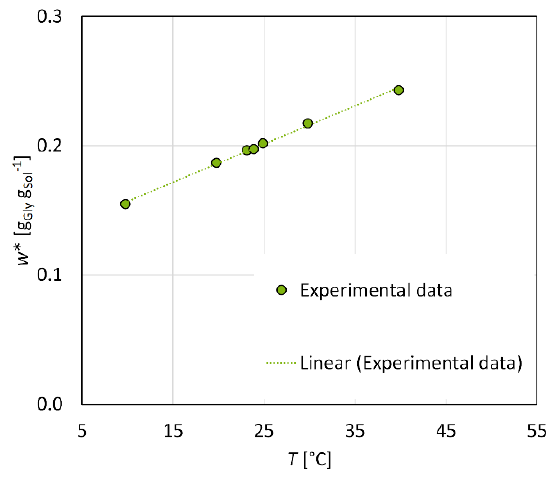
Figure A1. Solubility curve for glycine.